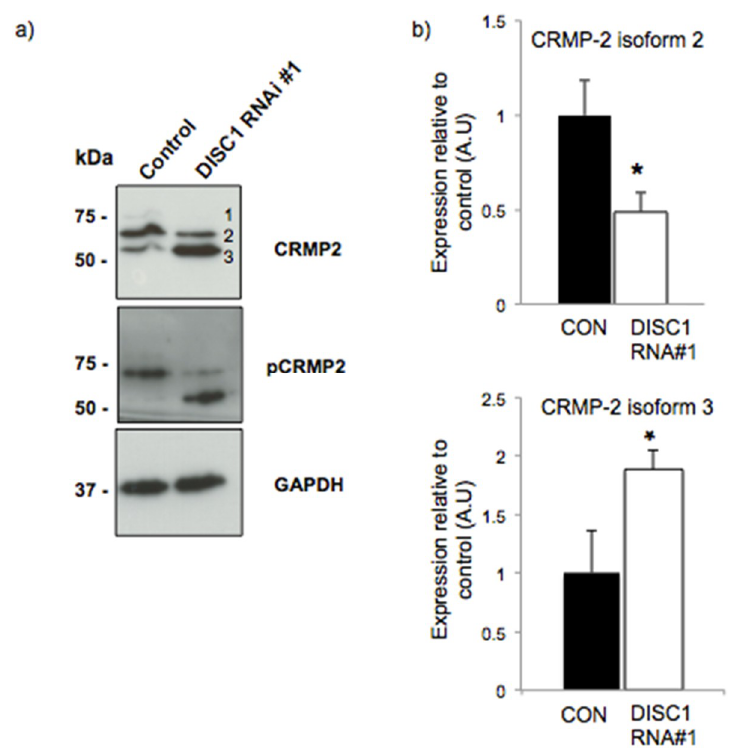
Figure 1. DISC1 differentially affects CRMP2 isoform levels. ( a ) Western blot of CRMP2 and pCRMP2 proteins. The total content of CRMP2 falls in DISC1 silenced cells, and the smallest one, thought to be a cleavage product, rises. The three isoforms are indicated (1–3). ( b ) Densitometric analysis of CRMP2 bands 2 and 3 ( n = 4, * p <0 .05).